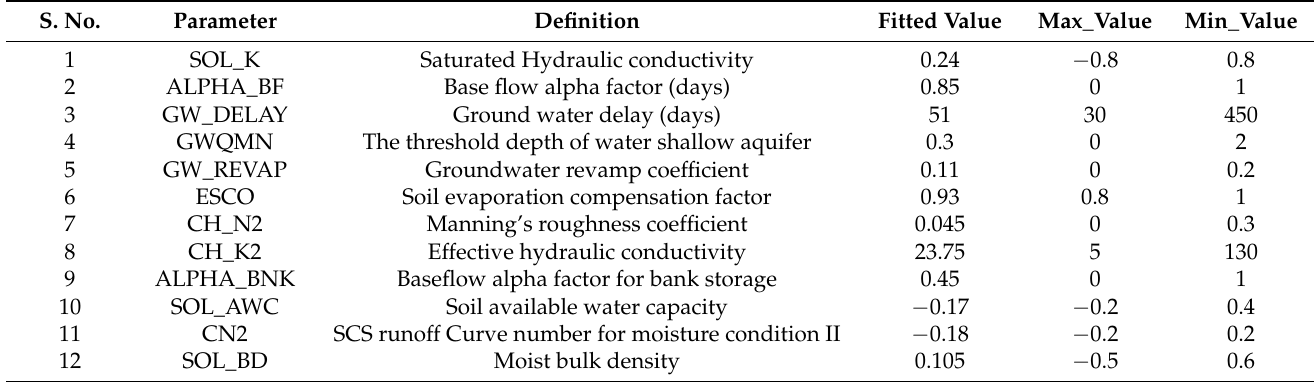
Table 13. Streamflow sensitivity